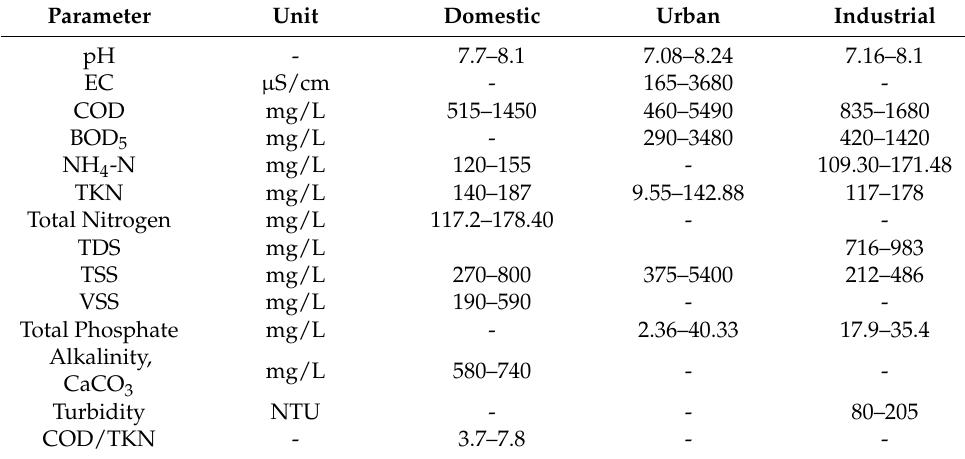
Table 2. Characteristics of black wastewater [50–52].